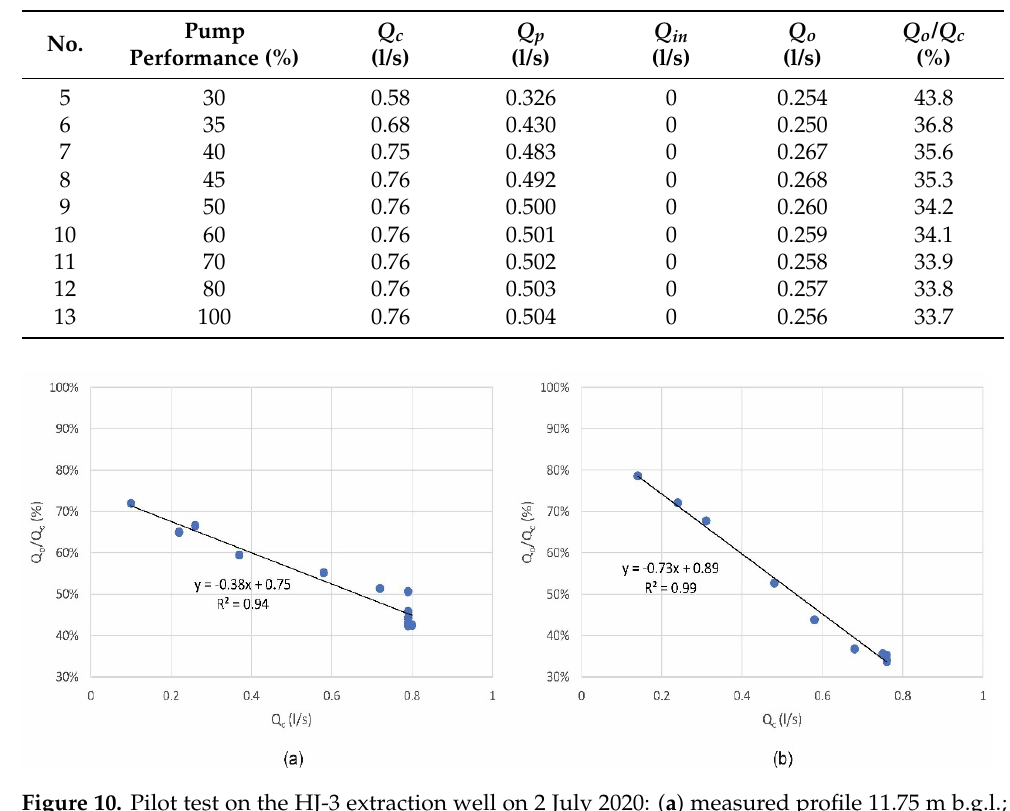
Table 9. Pilot test on the HJ-3 extraction well on 2 July 2020 (measured profile 15.75 m b.g.l.).